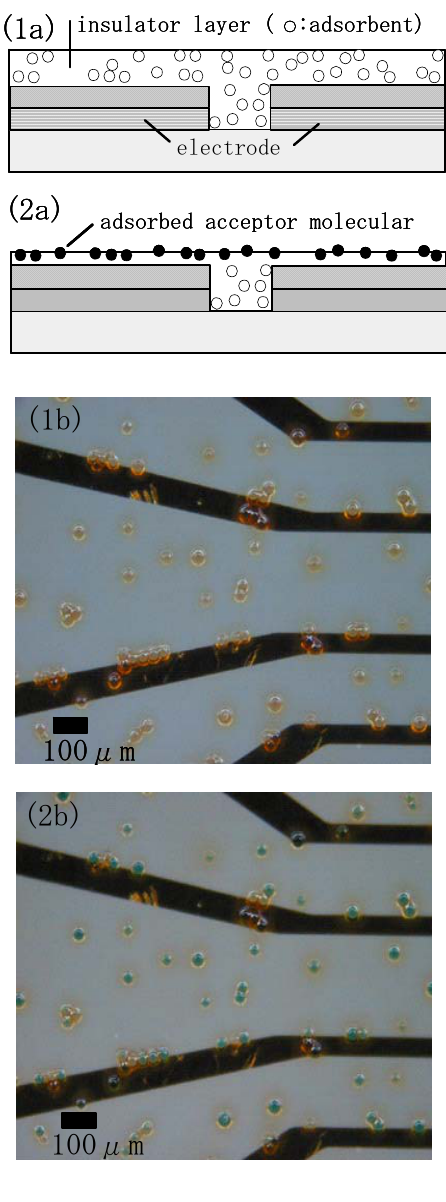
Figure 3. Fabrication steps for an electrode chip ( 1a – 2a ). Microscope images show an inter-electrode on a chip before ( 1b ) and after ( 2b ) wet-etching